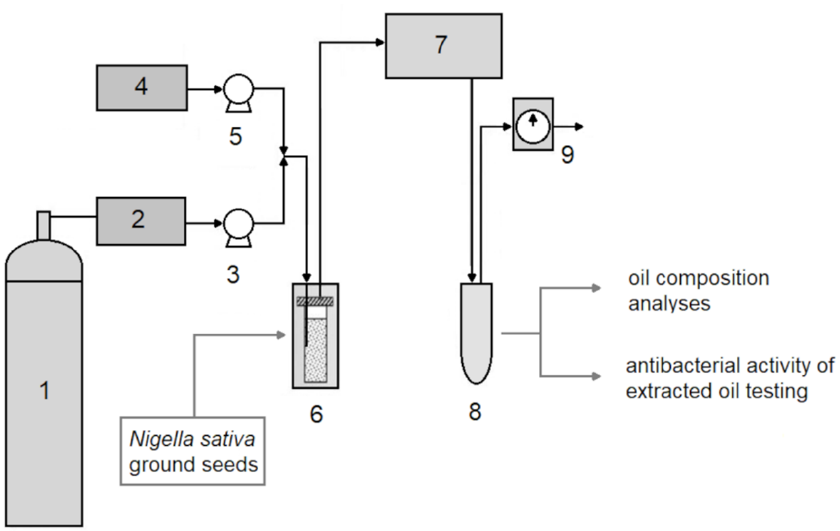
Figure 4. Flow diagram of a supercritical carbon dioxide extraction system (1. CO 2 supply; 2. cooling heat exchanger; 3. CO 2 pump; 4. co-solvent vessel; 5. co-solvent pump; 6. extraction oven with extraction vessels; 7. backpressure regulator; 8. sample collection; 9. wet gas meter and CO 2 release).